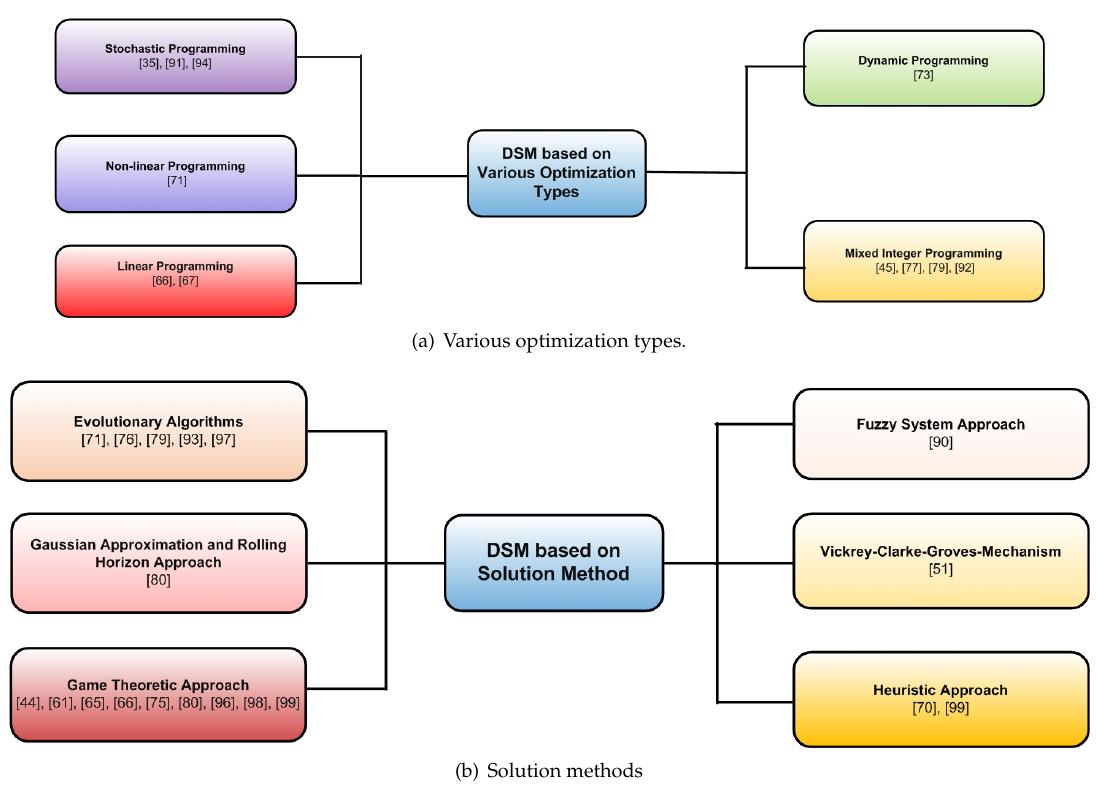
Figure 5. Optimization types and various methods for their